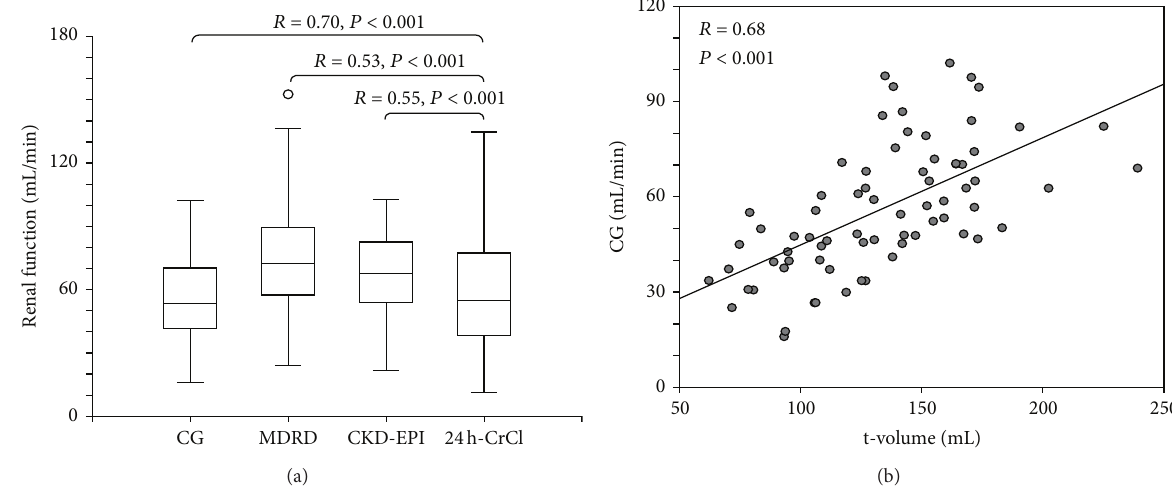
Figure 1: (a) Correlations between formulas for the estimation of renal function and 24 h-CrCl. (b) Correlation between the sum of left and right kidney volumes (t-volume) and renal function estimated by Cockcroft-Gault formula.